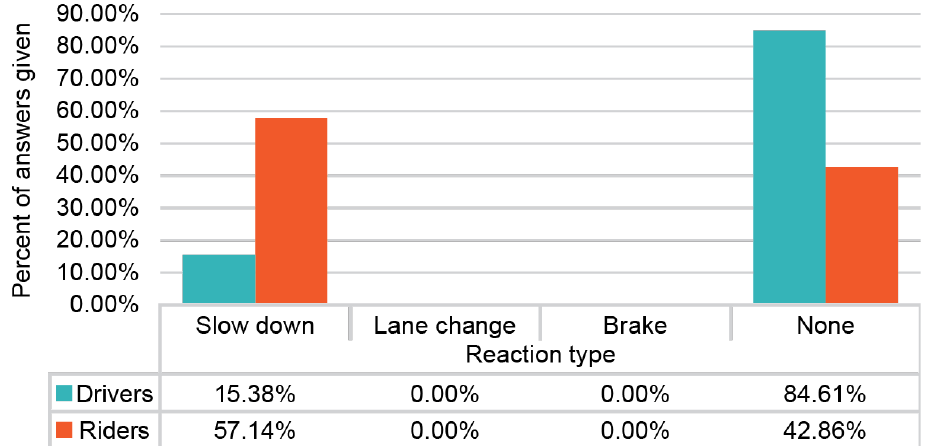
Figure 17. Recorded reactions for the scenario “ VMS ”